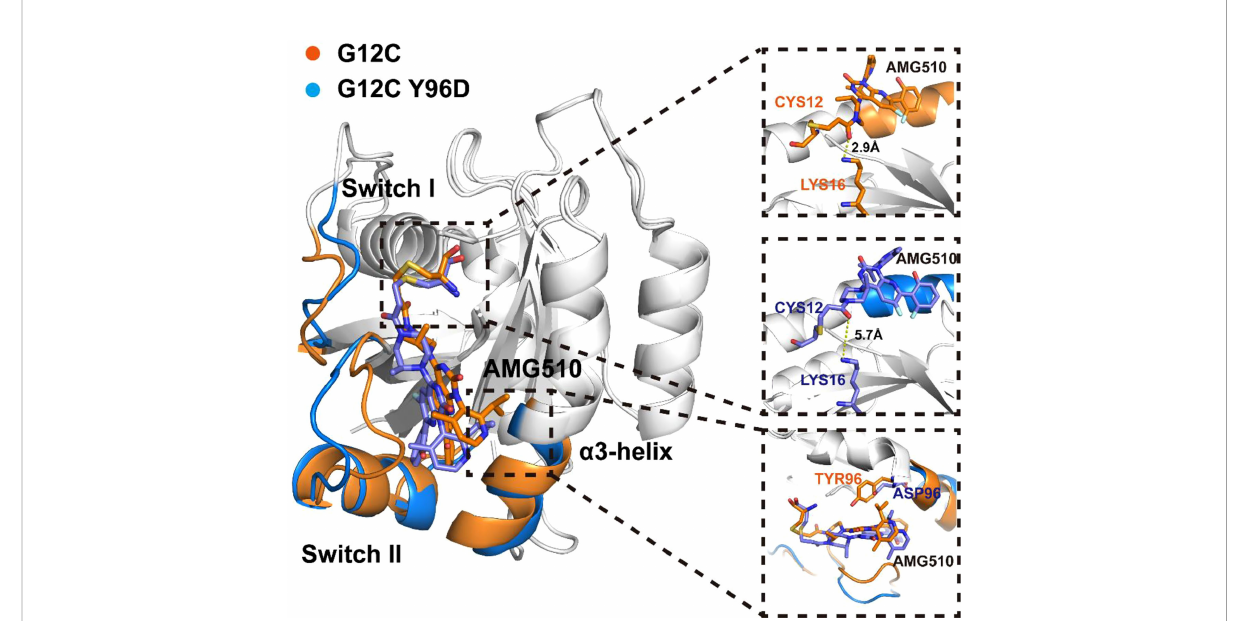
FIGURE 3 Superposition of the representative structures of the G12C system (orange) and the G12C/Y96D system (blue).